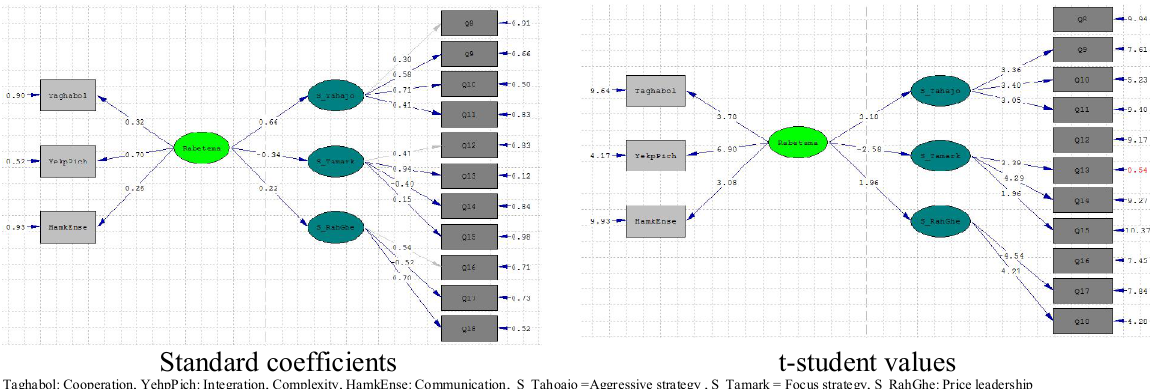
Fig. 3. The results of structural equation